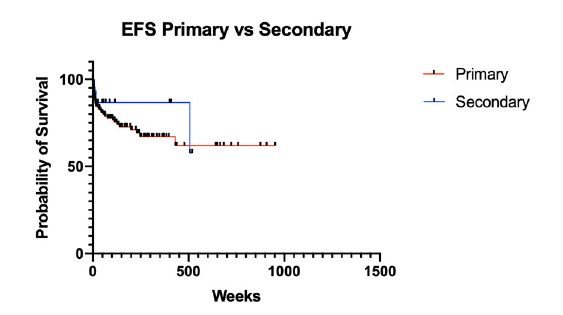
FIGURE2 Event free survival (EFS) for primary and secondary thyroid neoplasms.